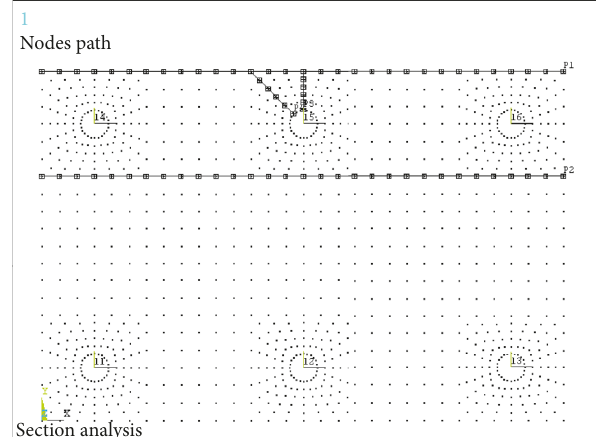
Figure 6: Schematic diagram of paths P1–P4.